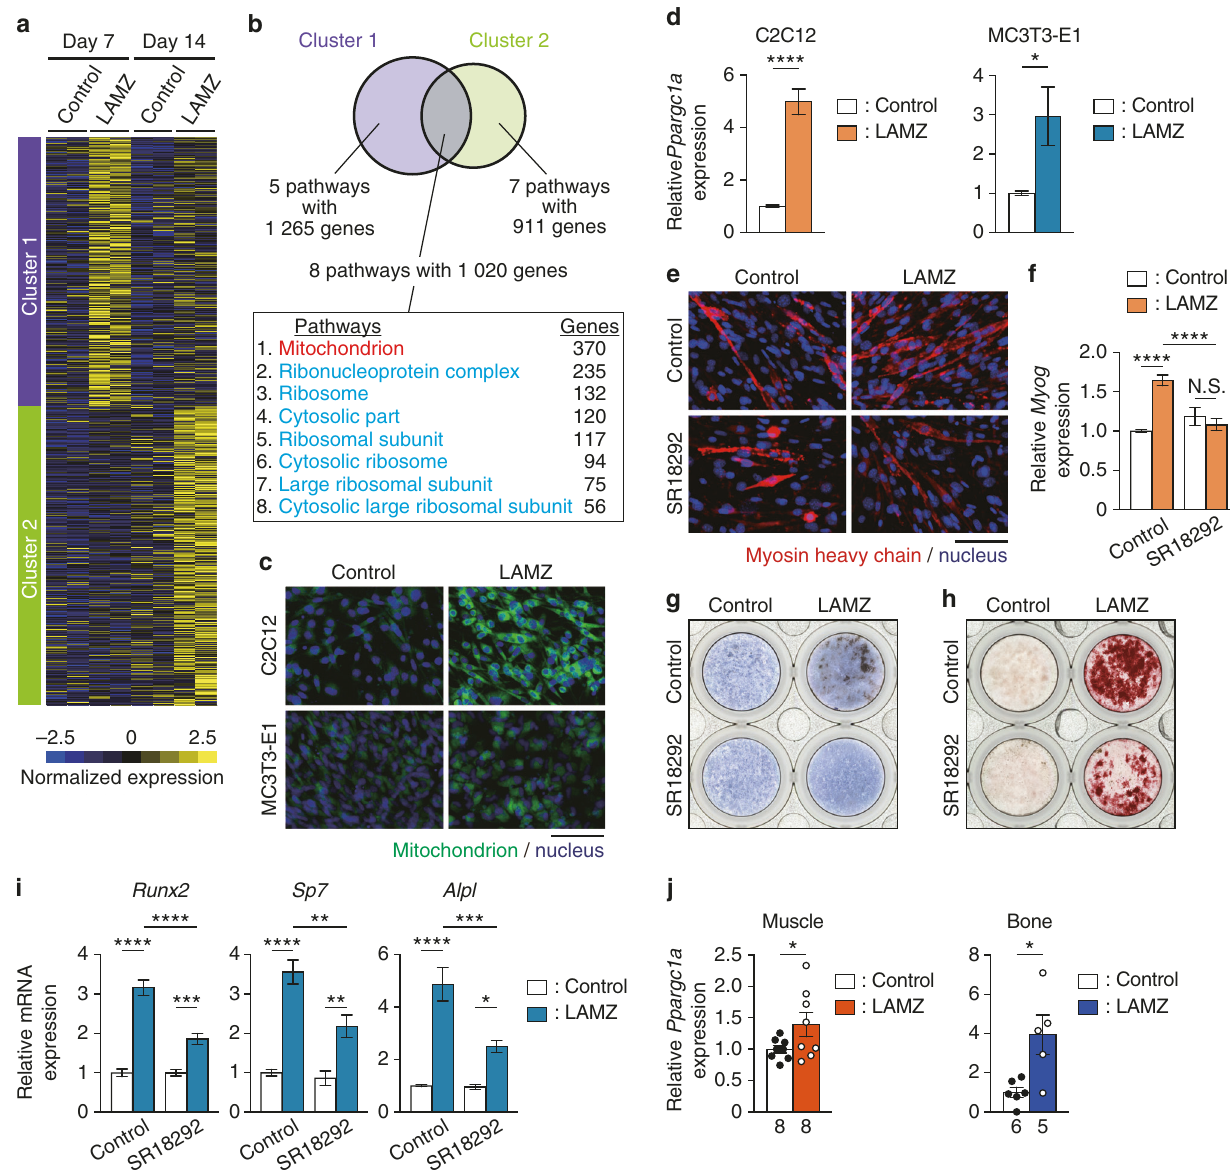
Fig. 3 PGC-1 α mediates the anabolic effects of LAMZ on muscle and bone. a Gene clustering analysis based on comprehensive gene expression pro fi les of LAMZ-treated cells. The genes upregulated by LAMZ were clustered. b Venn diagram indicating the pathways commonly enriched in the clusters. The numbers of pathways and genes are described. c Mitochondrial content in the cells treated with LAMZ. Mitochondria (green); nuclei (blue). d mRNA expression of Ppargc1a (PGC-1 α ) in the LAMZ-treated cells. e Representative immunocyto fl uorescence images of the C2C12 cells treated with the PGC-1 α inhibitor SR18292 together with LAMZ. Myosin heavy chain (red); nuclei (blue). f mRNA expression of Myog . g Representative ALP staining images of the MC3T3-E1 cells treated with SR18292 together with LAMZ. h Representative Alizarin Red S staining images of MC3T3-E1 cells. i mRNA expression of osteoblastic genes. j In vivo expression of Ppargc1a in the tissues of the mice orally administered LAMZ. In vitro experiments were repeated three times with replicates of 2 or 3 wells. Scale bar, 100 μ m. For the comparison of 2 groups, statistical analyses were carried out using Welch ’ s t test. For multiple comparisons, two – way ANOVA and Tukey ’ s multiple-comparison test were applied. The number of biological replicates is described below each bar. The error bars show the mean ± s.e.m. * P < 0.05; ** P < 0.01; *** P < 0.001; **** P < 0.000 1; N.S. not signi fi these results indicate that LAMZ facilitates the calcium signaling pathway to induce Mef2c and PGC-1 α , thus enhancing myogen- esis and osteogenesis.